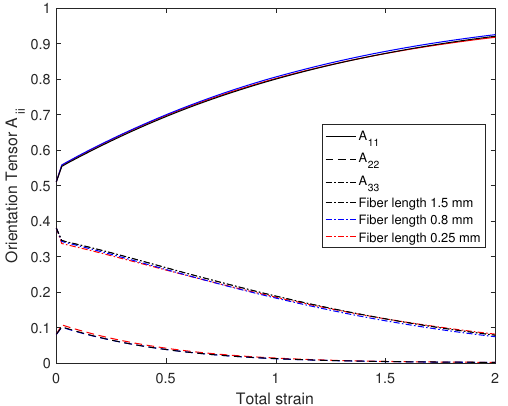
Figure 8. Fiber orientation evolution under elongational flow with different fiber lengths.